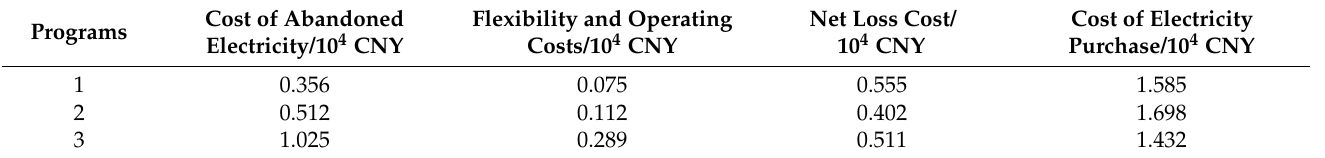
Table 7. The economic cost of the three methods.